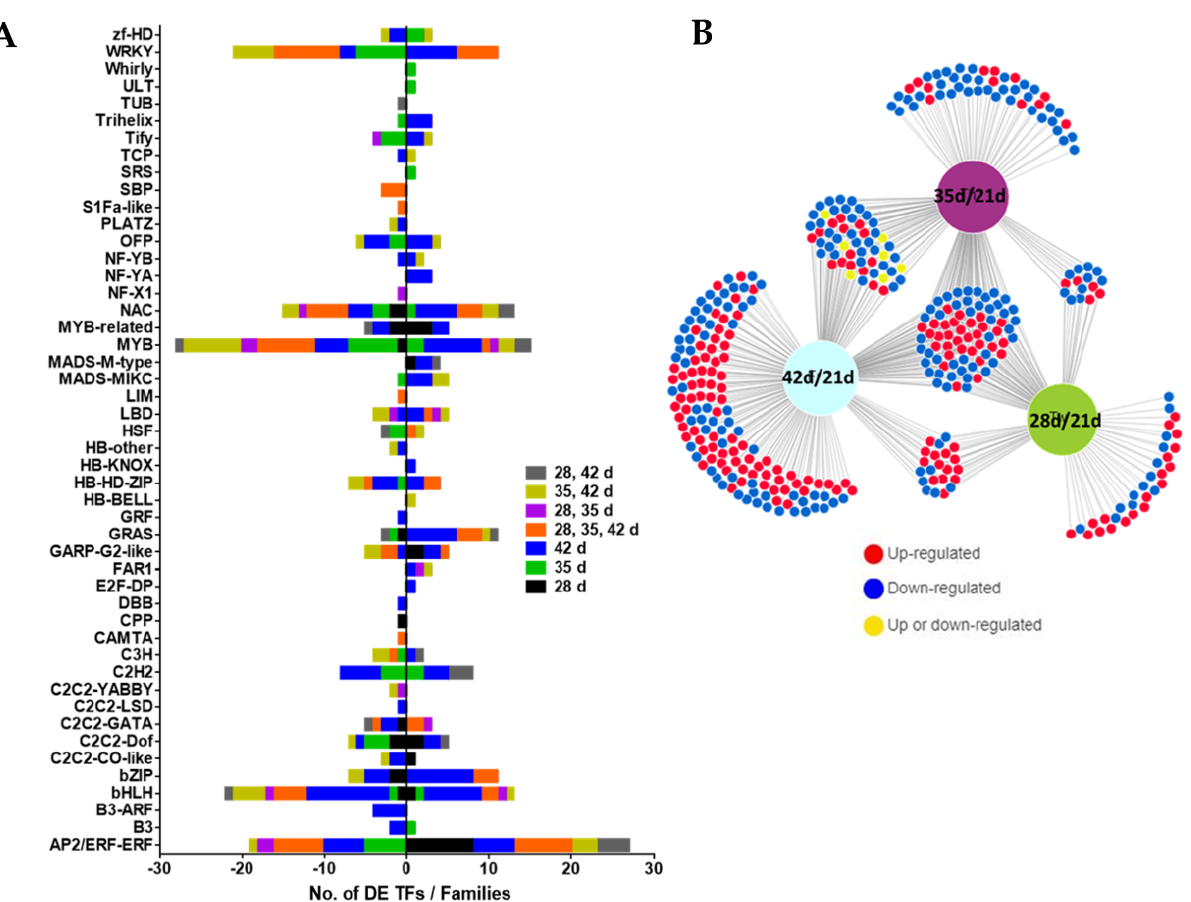
Figure 3. Transcriptional regulation of age-dependent senescence. ( A ) Graphical representation of DE TF families at 28, 35, 42 DAS vs. 21 DAS. ( B ) DiVenn analysis showing overlap among DE TFs in M3 leaves at 28, 35, 42 DAS vs. 21 DAS. Table 1. Transcription factor families with distinct expression kinetics during age-dependent senes- cence identified via STEM analysis.